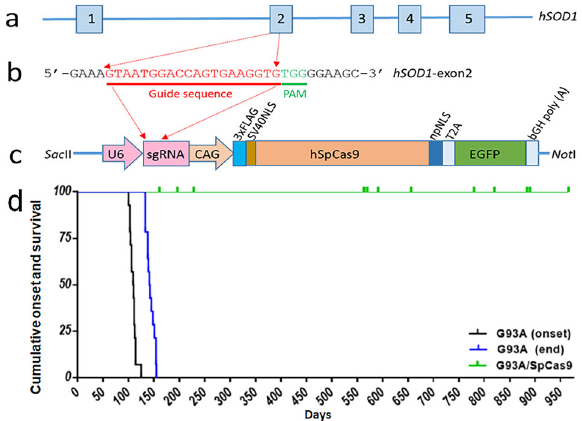
Fig. 1 Schematic representation of the human SOD1-SpCas9 transgene. a Human SOD1 structure. b A 20 bp DNA sequence (in red) of hSOD1 -exon2 was used to express guide RNA, and this 20 bp sequence was inserted into the BbSI site of a plasmid vector, pSpCas9 (BB)-2A-GFP (PX458) ( c ). The plasmid DNA was digested with Sac II and Not I. The 7.5 kb transgene was used for microinjection into mouse fertilized eggs. The protospacer adjacent motif (PAM) is shown in green ( b ). U6 U6 promoter, sgRNA single guide RNA containing a targeting sequence (crRNA sequence), and a Cas9 nuclease-recruiting sequence (tracrRNA), CAG a hybrid promoter 26 , SV40NLS simian virus 40 nuclear localization signal, hSpCas9 a human codon optimized SpCas9, npNLS nucleoplasmin nuclear localization signal, T2A a viral 2A self-cleaving peptide, EGFP enhanced green fl uorescent protein, bGH poly (A) bovine growth hormone poly (A) signal. Diagrams are not drawn to scale for clarity. d Kaplan – Meier plots showing the age of onset (black line, 109.5 ± 6.3 days) and cumulative survival (end stage, blue line, 141.5 ± 8.1 days) of G93A high expresser line (G1H, n = 14) and G1H/ Cas9 double transgenic mice (green, n = 15). The G1H/Cas9 mice did not develop an ALS-like